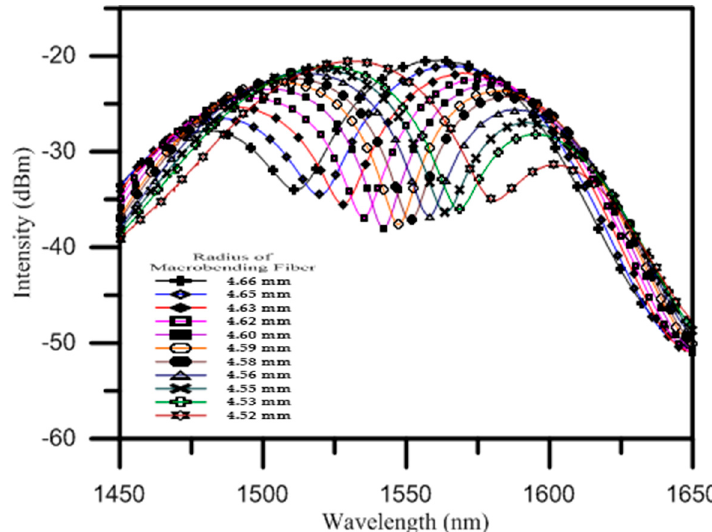
Figure 3. The interference spectra of the WGM edge filter with different bent radii for etched single ‐ mode fiber.